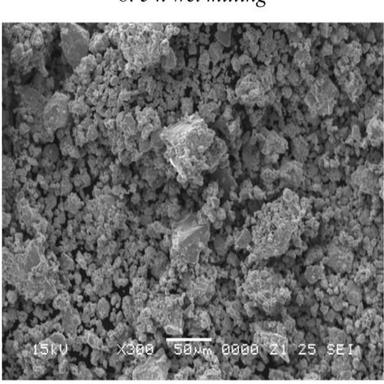
SEM images for starting sample and ball-milled powders in dry and wet milling conditions: a - starting sample (SS); b - 5 h wet-milled sample; c - 5 h dry-milled sample; d - 40 h wet-milled sample; e - 40 h dry-milled sample.